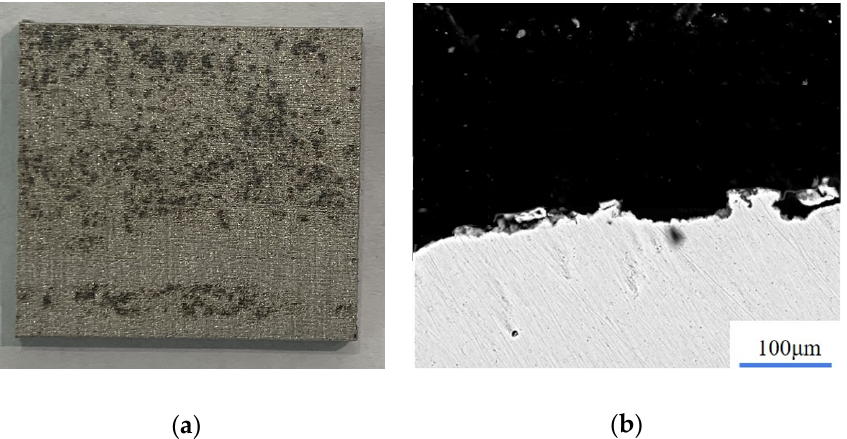
Figure 12. Surface morphology after complete cleaning. ( a ) Morphology of sample after cleaning twice; ( b ) thickness of residual oxide.